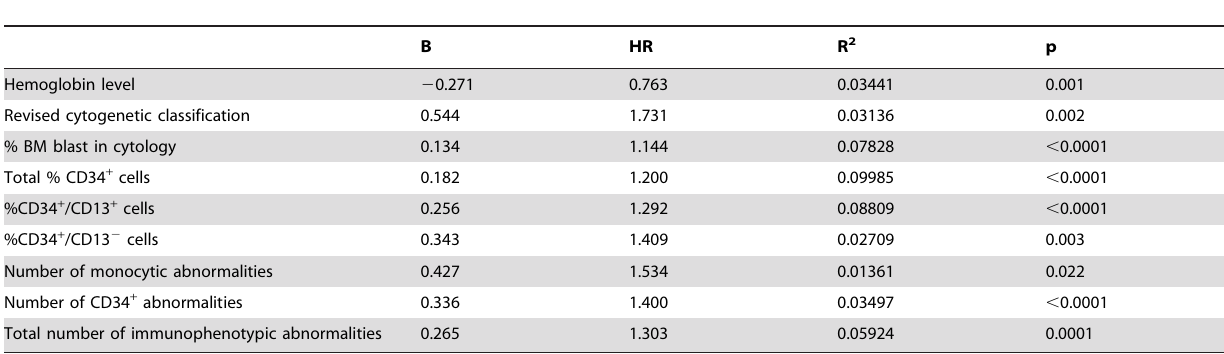
Table 6. Prognostic single variables that showed a significant association with overall survival in the univariate Cox